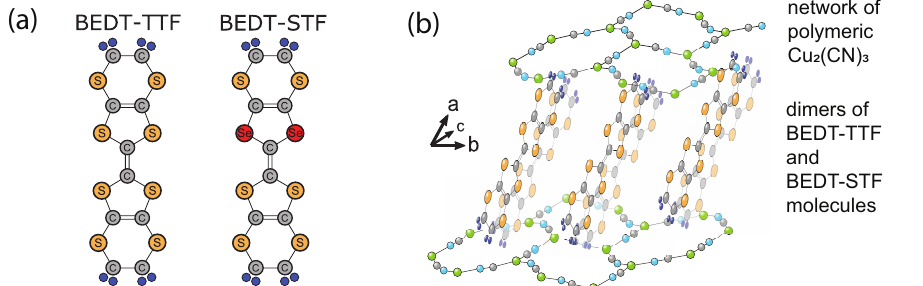
Figure 2. ( a ) Organic donor molecules bis-(ethylenedithio)-tetrathiafulvalene (BEDT-TTF) and bis- (ethylenedithio)-diseleniumdithiafulvalene (BEDT-STF). In the latter case, two sulfur atoms of the inner rings are replaced by selenium. ( b ) The crystal structure contains dimers of the donor molecules forming layers in the bc -plane, which are separated by the Cu 2 (CN) 3 anion sheets. The compounds therefore constitute prime examples of two-dimensional conductors and